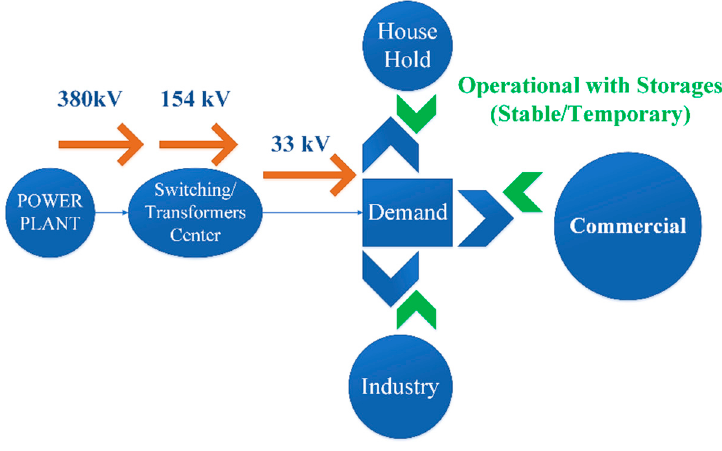
Figure 2. Energy injection side and areas can be operational by storages.